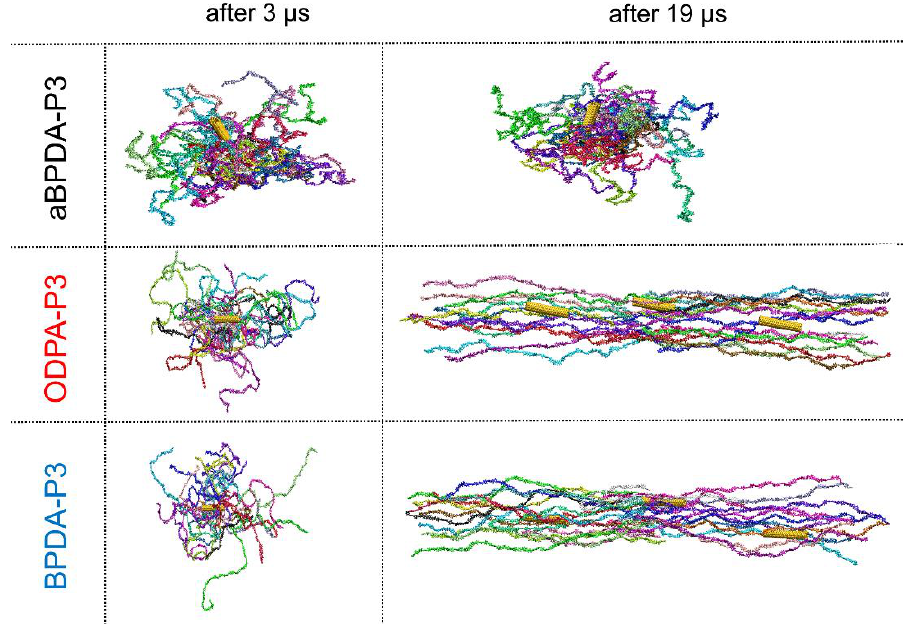
Figure 4. The instant configurations of a single periodic cell of the SWCNT-PI nanocomposites based on aBPDA-P3 ( top ), ODPA-P3 ( middle ), and BPDA-P3 ( bottom ) after 3 and 19 microseconds of simulation. The periodic boundary conditions were removed and polymer chains are drawn continuously to show the conformation of PI chains in each system. For the systems where polymer chains are unfolded and oriented, two additional periodic images of SWCNT are shown which are in contact with the PI chains depicted. Each polymer chain is shown in its own color. The SWCNT is shown in yellow on all the snapshots.